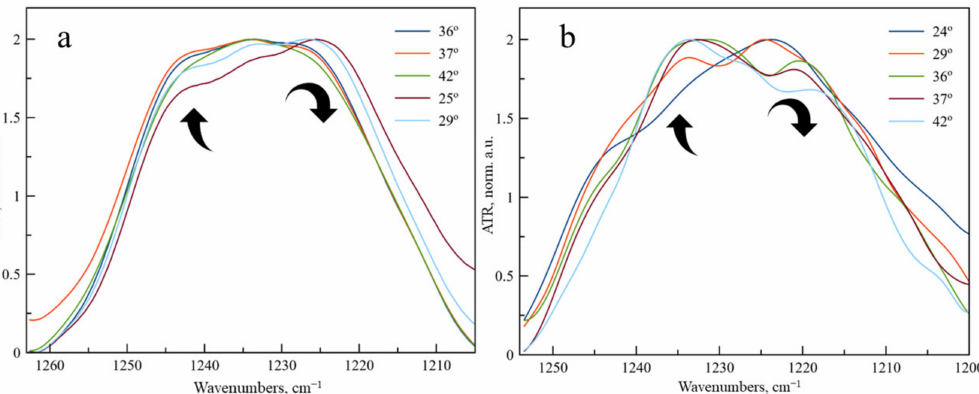
Figure 3. Normalized ATR-FTIR spectra of LLev ( a ) DPPC and ( b ) DPPC:CL 80:20 liposomes at vari- ous temperatures. Total lipid concentration 5 mg/mL. 0.02 M Na phosphate-buffered solution, pH